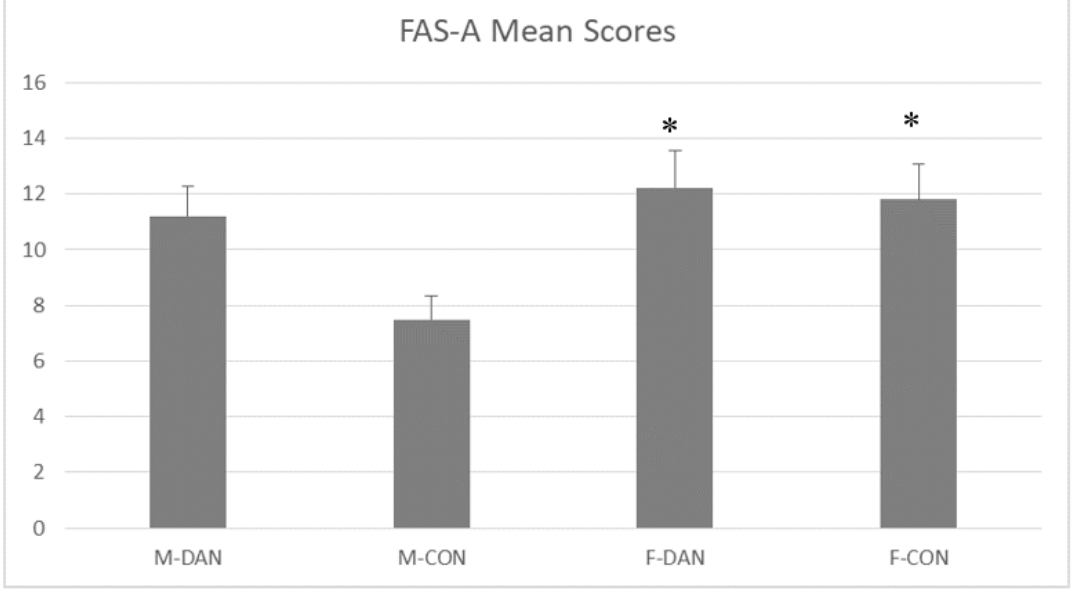
Figure 4. FAS Word Fluency Test mean scores. Women outperformed men in this task. This was independent of the practice of dancing. Male dancing (M-DAN); female dancing (F-DAN); male control (M-CON); female control (F-CON). Mean + SEM. * Significant differences with men (p<0.05). Scores of Animal Naming were also analyzed. ANOVA revealed that there were neither a significant main effect of Gender, F(1,43) = 1.72; p = 0.190), nor Group, F(1,43) = 2.56; p = 0.110), but a statistically significant interaction Gender x Group, F(1,43) = 8.23; p = 0.006). A post-hoc analysis (Fisher LSD Post-hoc test) showed that men in the dancing group ( X(cid:3365) = 21.85) and women in the